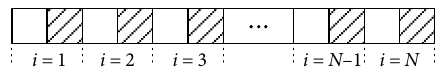
Figure 3: Real number encoding method.